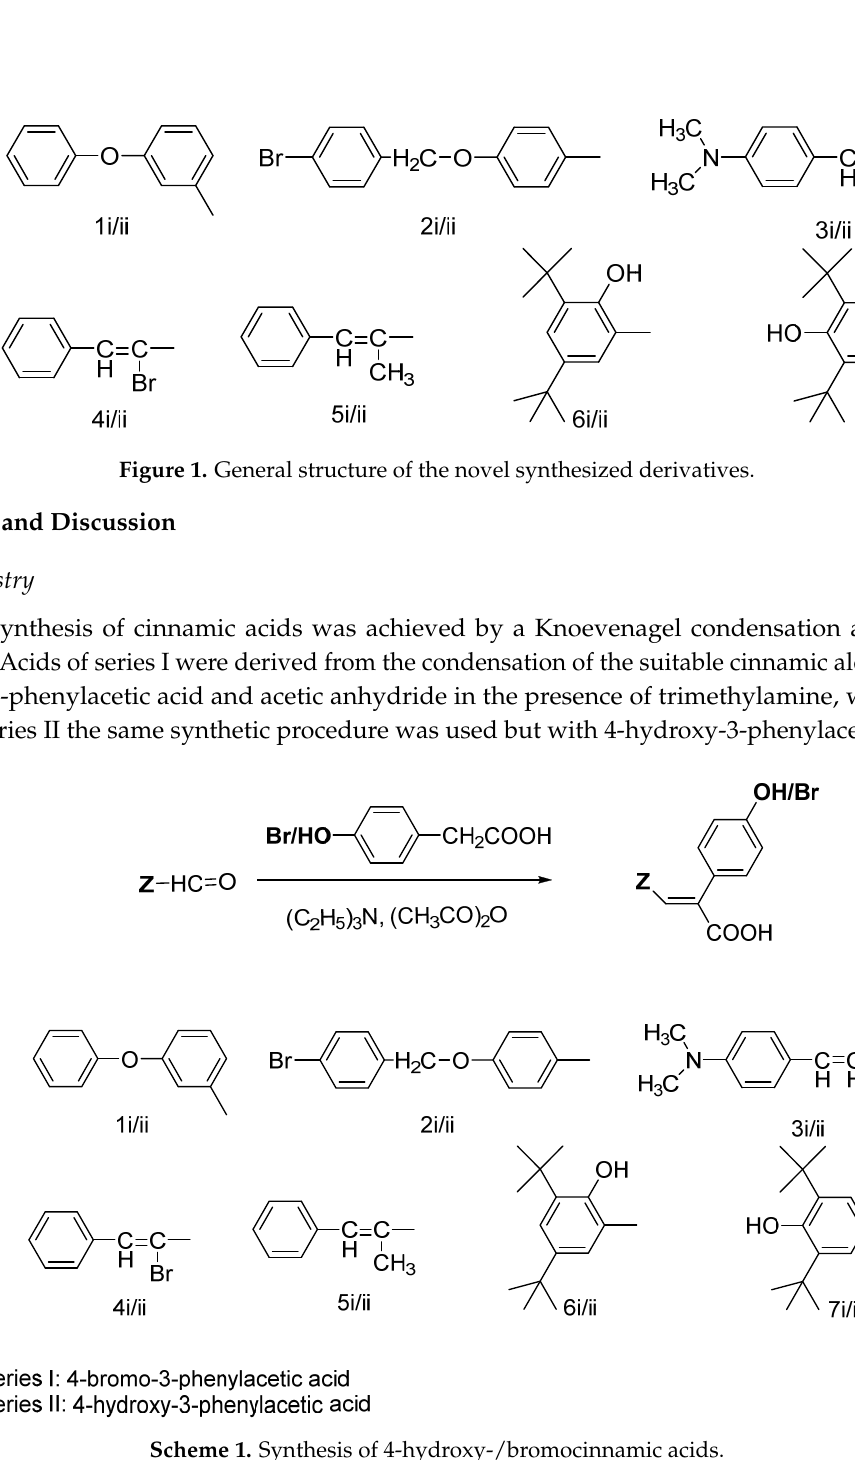
Scheme 1. Synthesis of 4-hydroxy-/bromocinnamic acids.